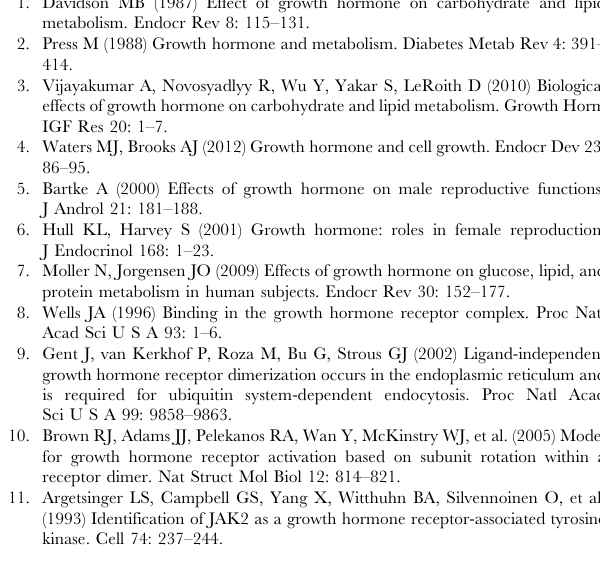
Figure S1 Structures of predicted novel miRNAs. For each novel miRNA, the precursor name, position, strand, length and energy are shown in the first line. The sequence of precursor and total reads are described in the second line. The brackets in the third line denote the secondary structure. The sequence of major unique reads, novel miRNA name and the number of reads are shown below with ‘*’. Then the sequence of each unique reads and the number of reads are shown below with ‘ 2 ’.